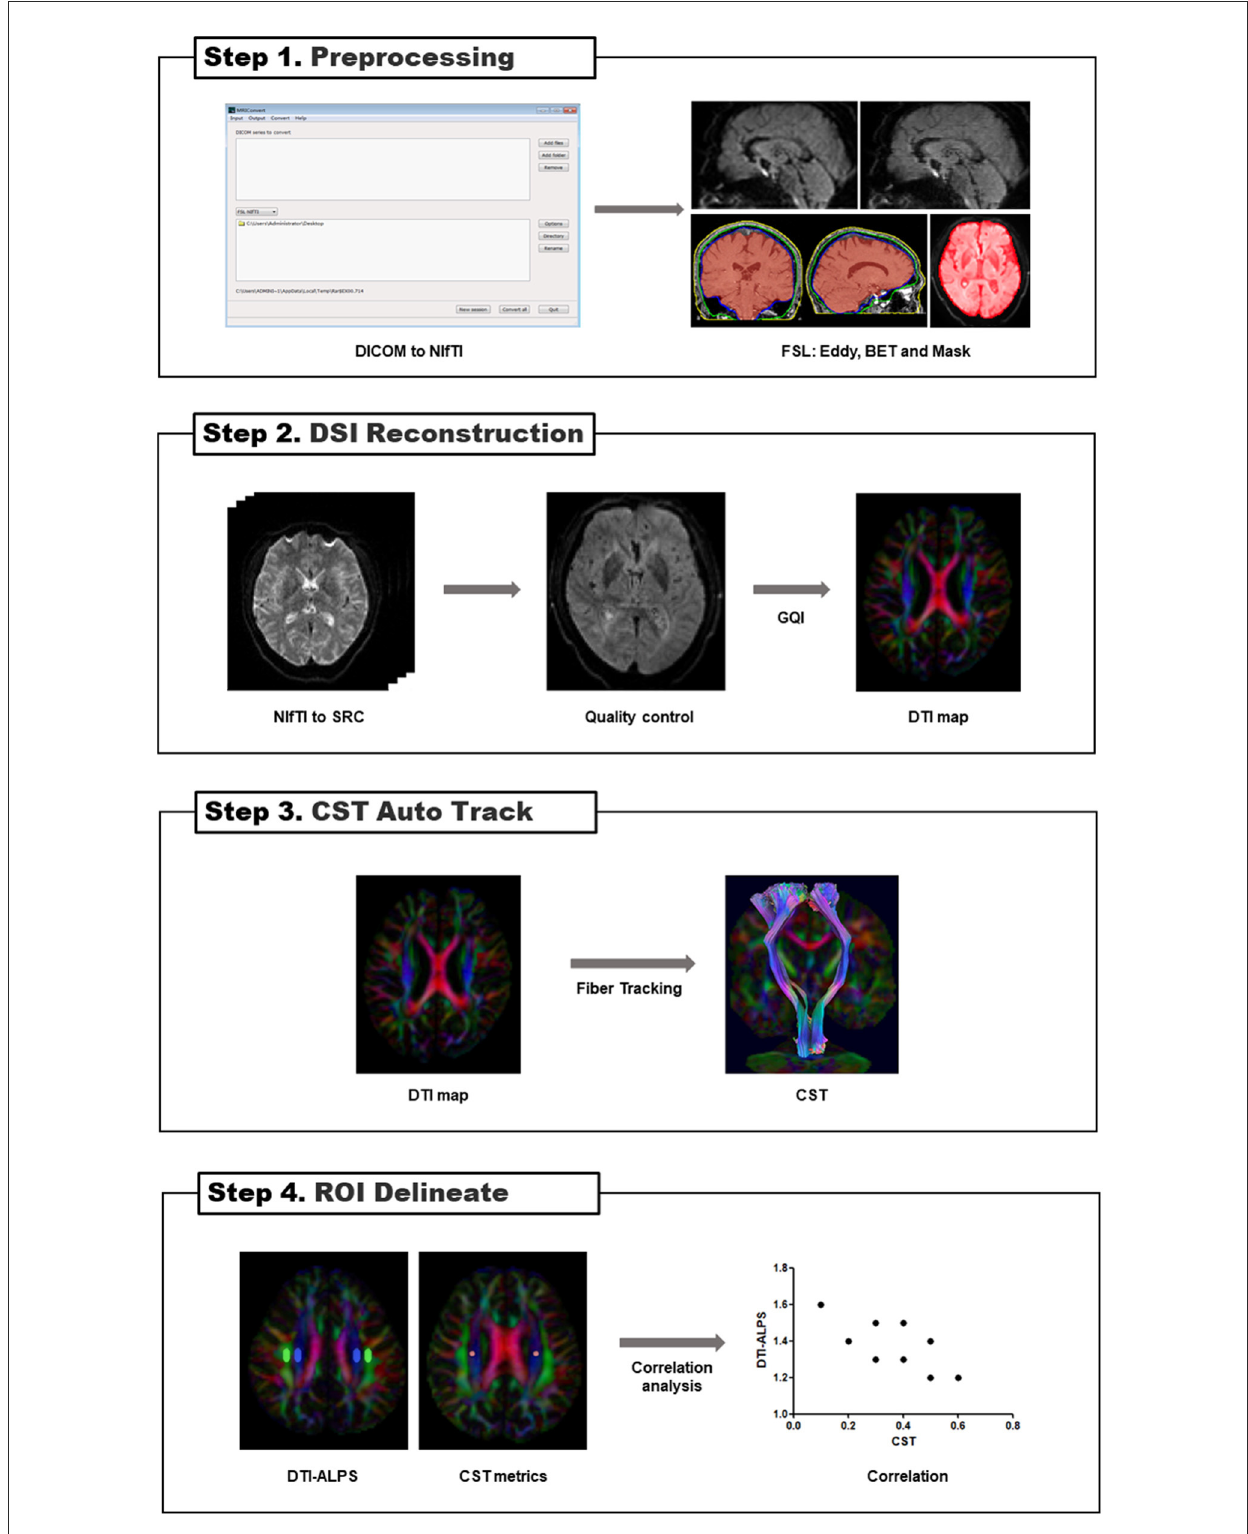
FIGURE2 Flowcharts for DSI image processing. BET, brain extraction tool; GQI, generalized q-sampling imaging; DSI, diffusion spectrum images; DTI, diffusion tensor image; CST, corticospinal tract; DTI-ALPS, diffusion tensor image analysis along the perivascular space; ROI, regions of